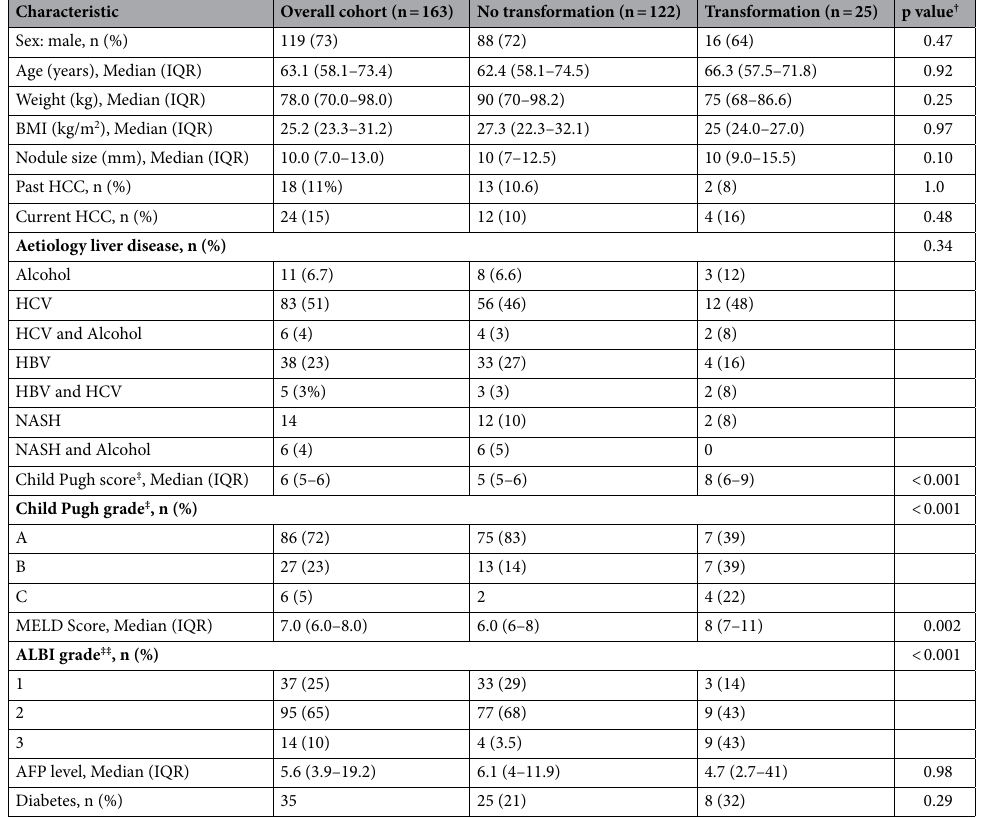
Table 1. Baseline demographic, clinical and nodule characteristics of the overall nodule cohort and in nodules that did and did not transform to hepatocellular carcinoma. AFP, alpha-fetoprotein; ALBI, albumin-bilirubin grade for hepatocellular carcinoma; BMI, body. mass index; HCC, hepatocellular carcinoma; HBV, hepatitis B virus; HCV, hepatitis C virus; MELD, model for end-stage liver disease; NASH, non-alcoholic steatohepatitis. ‡ in 44 (27%) nodules the result was not available. ‡‡ in 17 (10.4%) of nodules the result was not available. † Comparison of nodules that transformed to HCC versus nodules that did